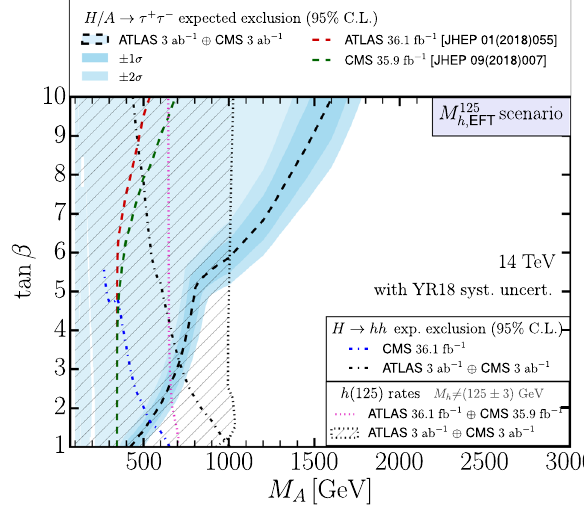
Fig. 4 HL-LHCprojectionsinthe M 125 scenariowiththesamecolor h , EFT coding as in Fig.2. The blue and black dash-dotted lines show the cur- rent CMS [91] and future HL-LHC expected 95% CL limit from a combination of H → hh searches (see Sect. 3 for details) The dashed black curve and blue filled region indicate the HL-LHC reach via direct heavy Higgs searches in the τ + τ − channel with 6 ab − 1 of data (with the dark blue regions indi- cating the 1 and 2 σ experimental uncertainty). The future HL-LHC sensitivity via combined ATLAS and CMS Higgs rate measurements is shown as black dotted contours, accom- panied with a hatching of the prospectively excluded